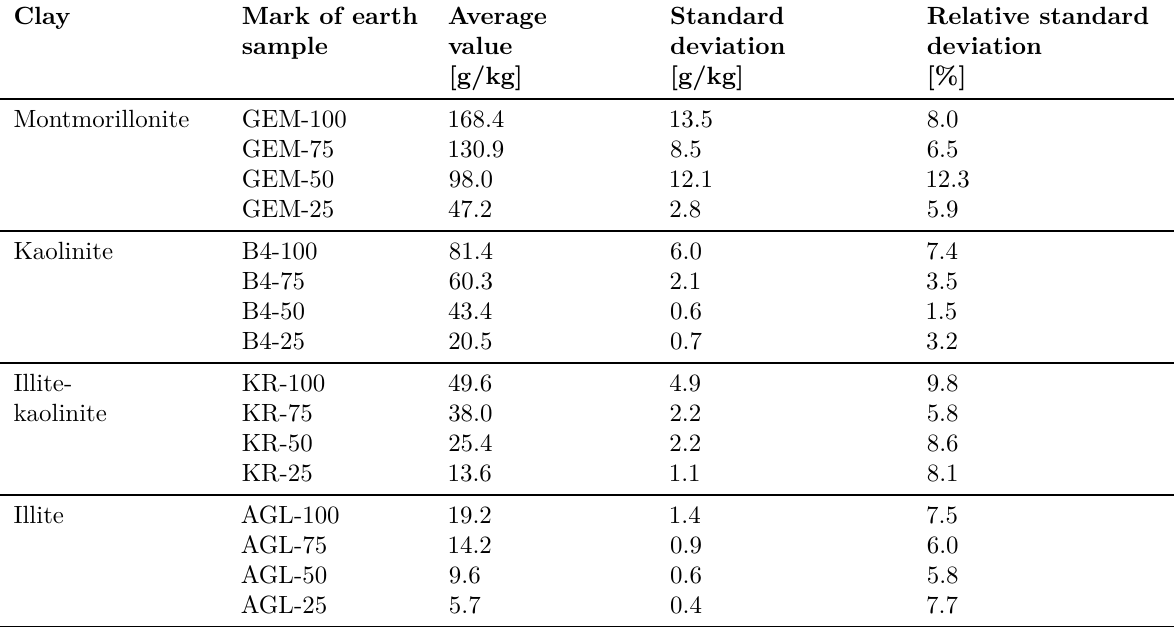
Table 3. Obtained results of the adsorption